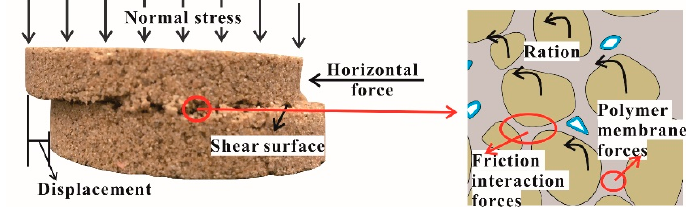
Figure 17. The schematic diagram of the specimen during the shear processing.